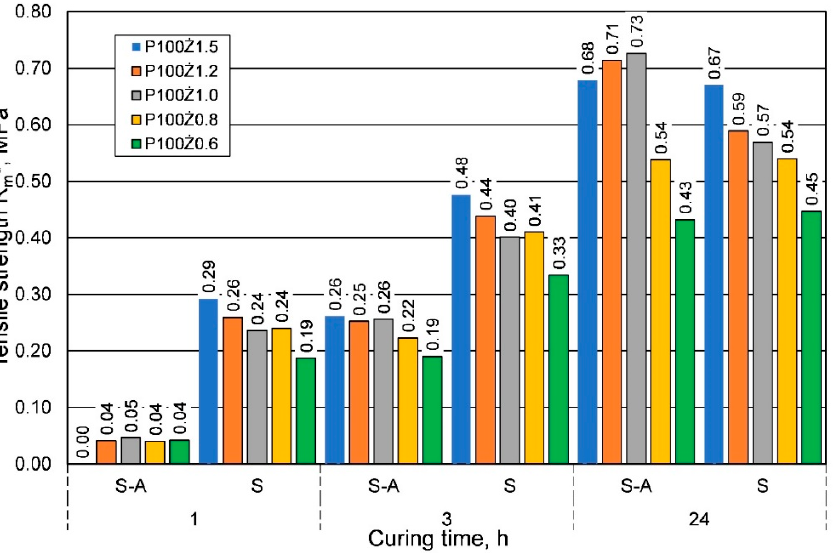
Figure 3. Tensile strength R u m of molding sand made on the basis of fresh chromite sand, depending on weather conditions, for different amounts of added binder.